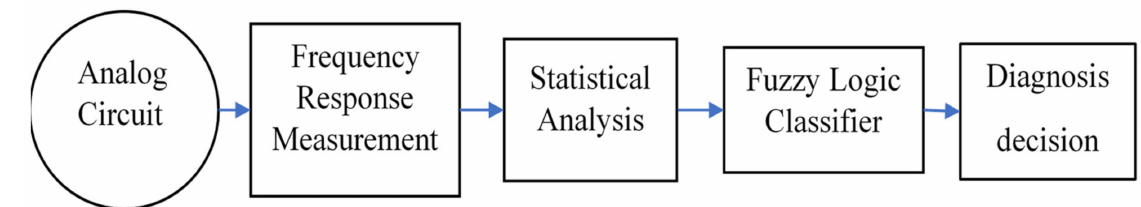
Figure 2. The proposed approach for analog electronic circuit fault detection using a fuzzy logic